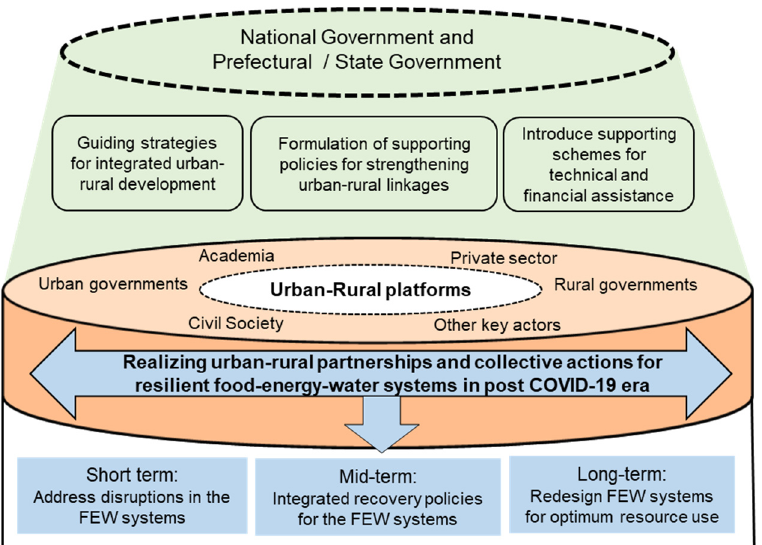
Figure 3. Framework of urban–rural partnership for capturing multiple benefits (image source: au- thors).